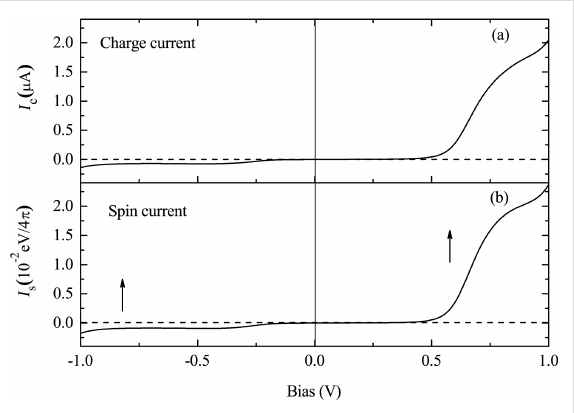
Figure 10: Bias-dependent (a) CC and (b) SC for N = 32 and E F = 0.3 eV. The arrows in panel (b) indicate the SP of the current. Reproduced with permission from [33], copyright 2008 AIP Publishing.